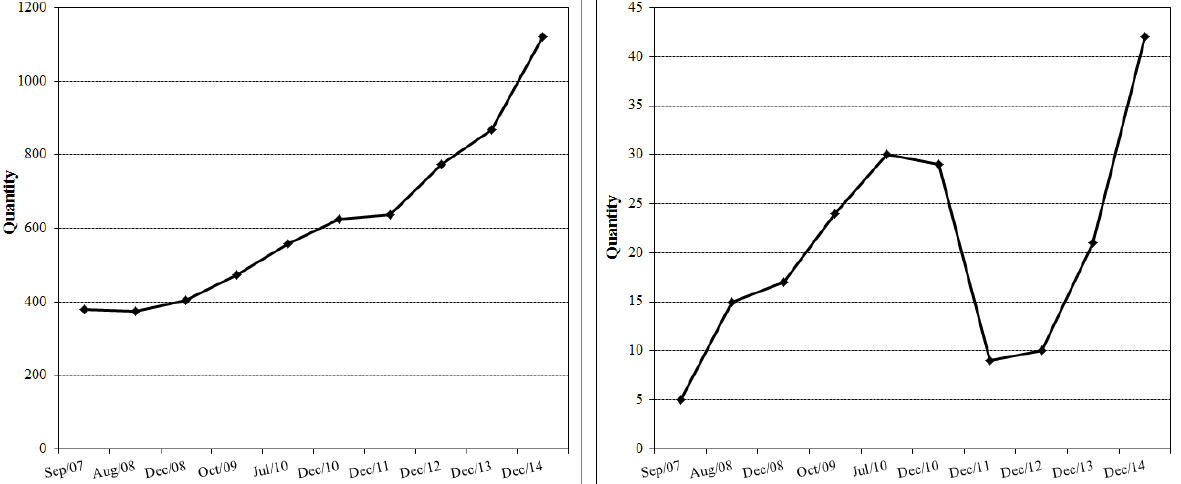
Based on the data provided by both Figures 1 and 2 one should stress that a remarkable high percentage of the certified OHSMSs are integrated with other management subsystems. In fact, the percentage of companies that adopted a single OHSMS is fairly low (Figure 3) being around 3.7% considering the last available data.